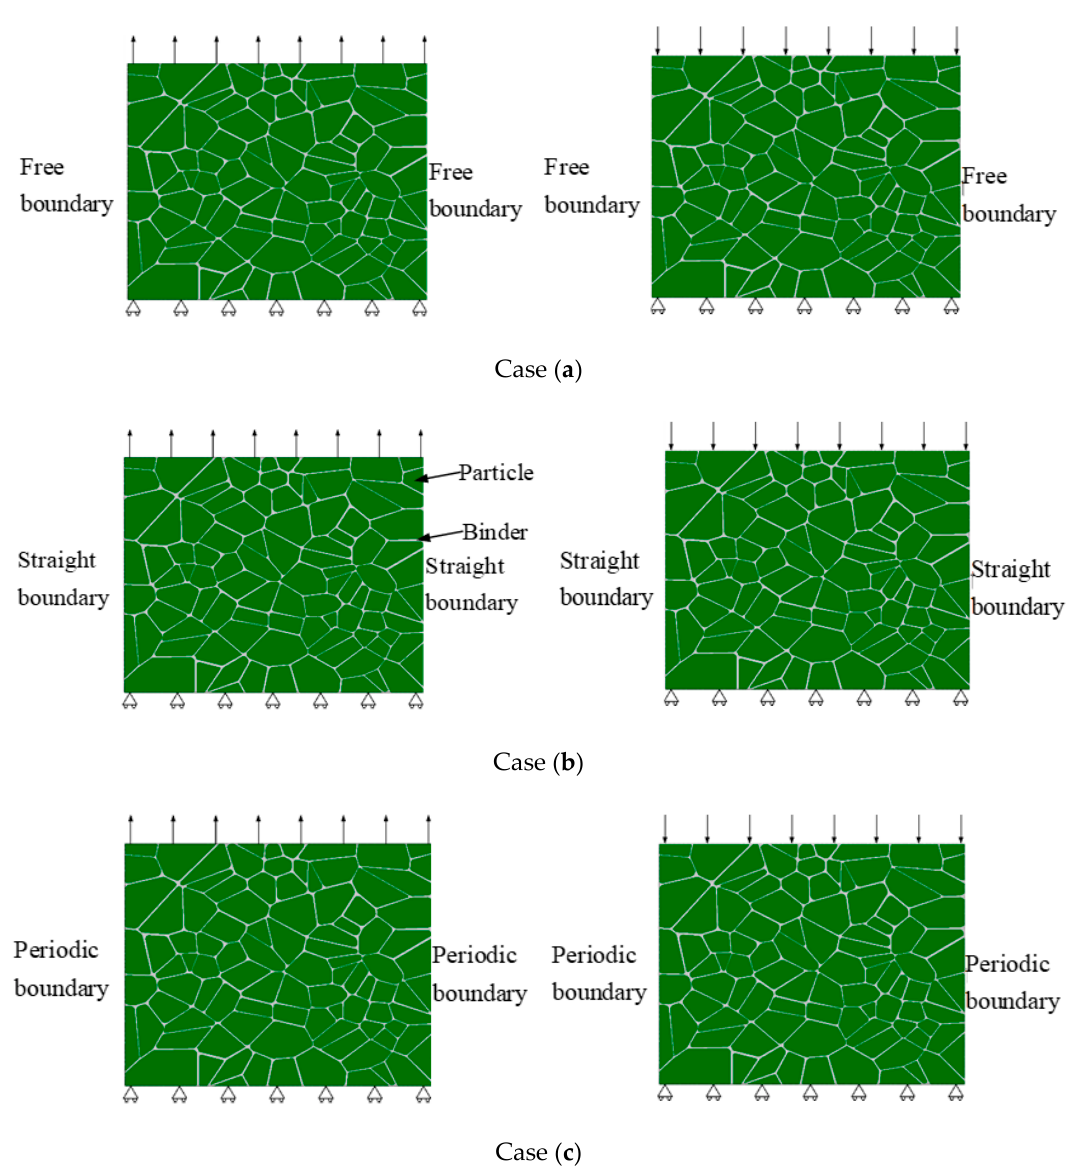
Figure 10. Loading and the three boundary conditions; case ( a ) traction free vertical edges, case ( b ) straight vertical edges, and case ( c ) periodic vertical edges.